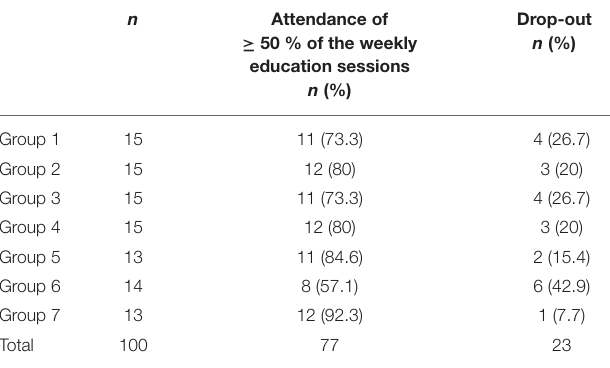
TABLE 4 | Summary of the intervention group attendance rate during the implementation of the nutrition education